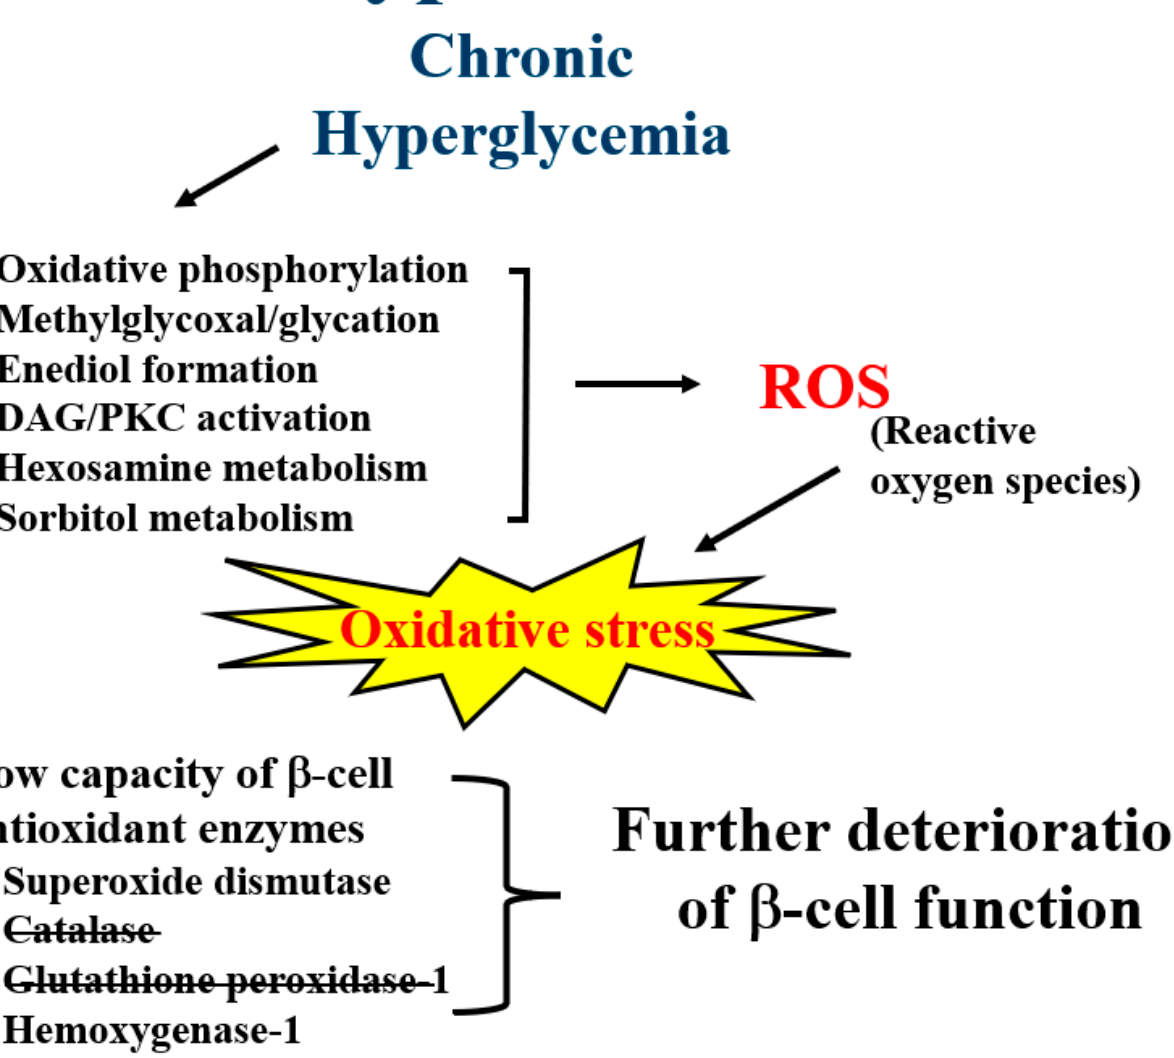
Figure 2. Hypothesis: Under conditions of supraphysiologic concentrations of blood glucose, various metabolic pathways generate increasing levels of ROS in body tissues, including the pancreatic beta cell. The normal beta cell, however, does not contain the full complement of antioxidant enzymes found in other tissues, specifically catalase and glutathione peroxidases, which are important regulators of intracellular ROS levels and catabolism. Consequently, ROS are abundant in beta cells and cause oxidative damage.